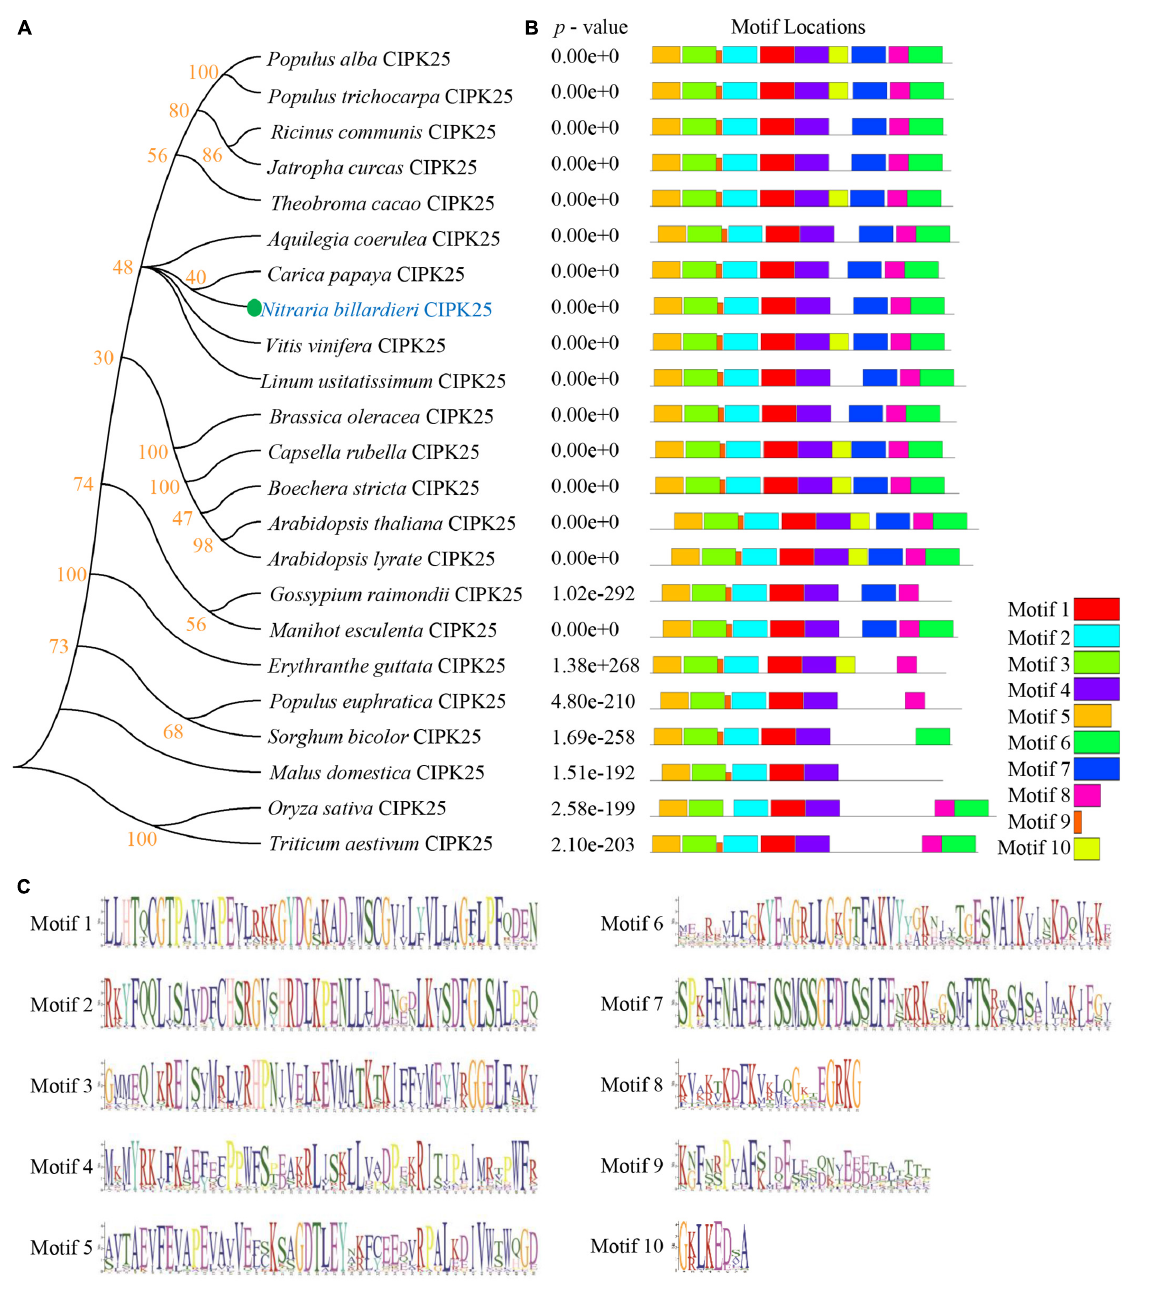
(Liu et al., 2015; He et al., 2018; Wang et al., 2018).